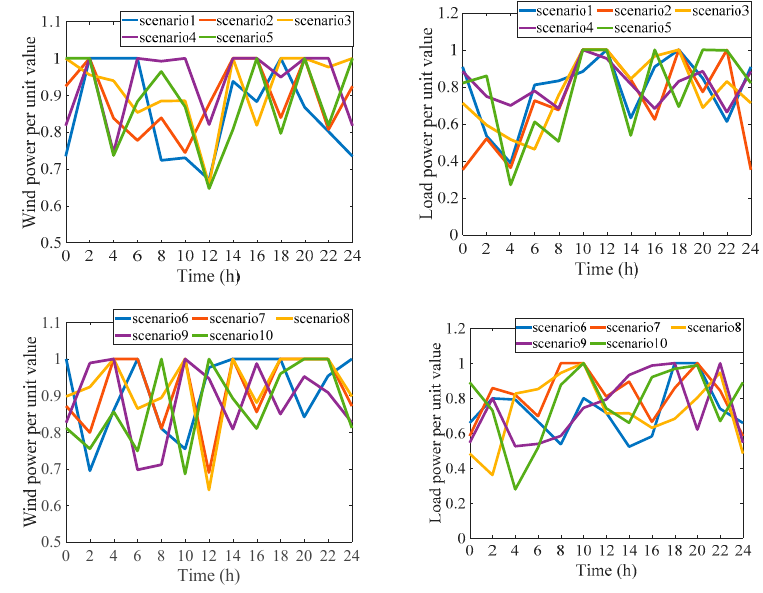
Figure A2. Ten random scenarios of load and wind power.